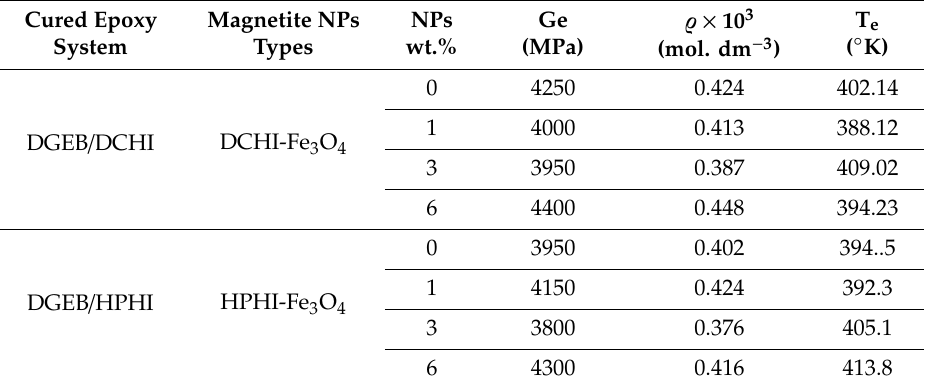
Table 4. DMA and crosslinking densities data of DGEB / DCHI and DGEB / HPHI systems in the absence or presence of HPHI-Fe 3 O 4 and DCHI-Fe 3 O 4